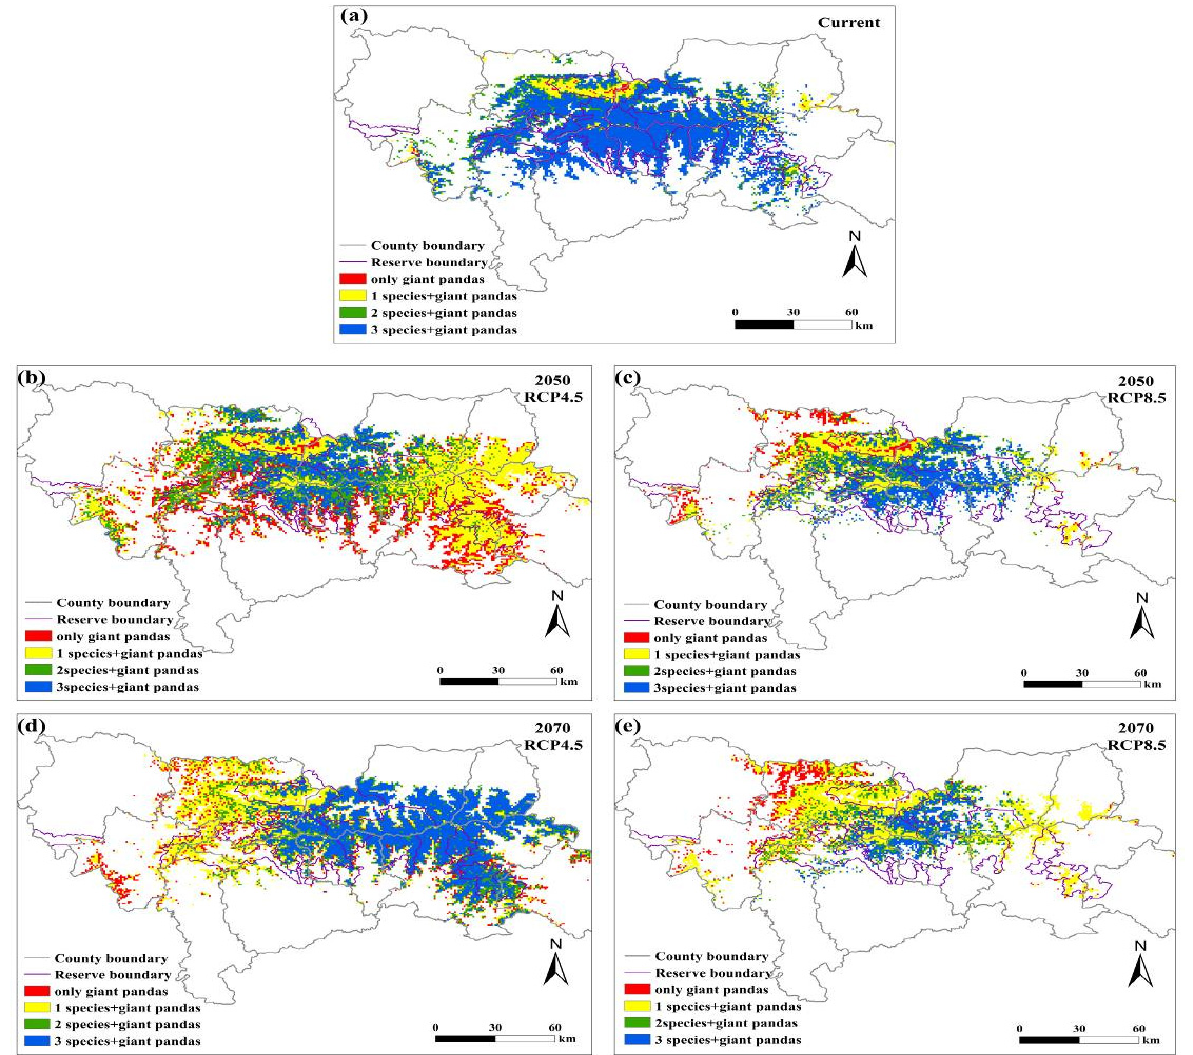
Figure 5. Overlapping distributions of the suitable habitats for giant pandas, black bears, golden takins, and wild boars in the Qinling Mountains under the ( a ) current climate, ( b ) RCP4.5 scenario in 2050s, ( c ) RCP8.5 scenario in 2050s, ( d ) RCP4.5 scenario in 2070s, and ( e ) RCP8.5 scenario in 2070s.